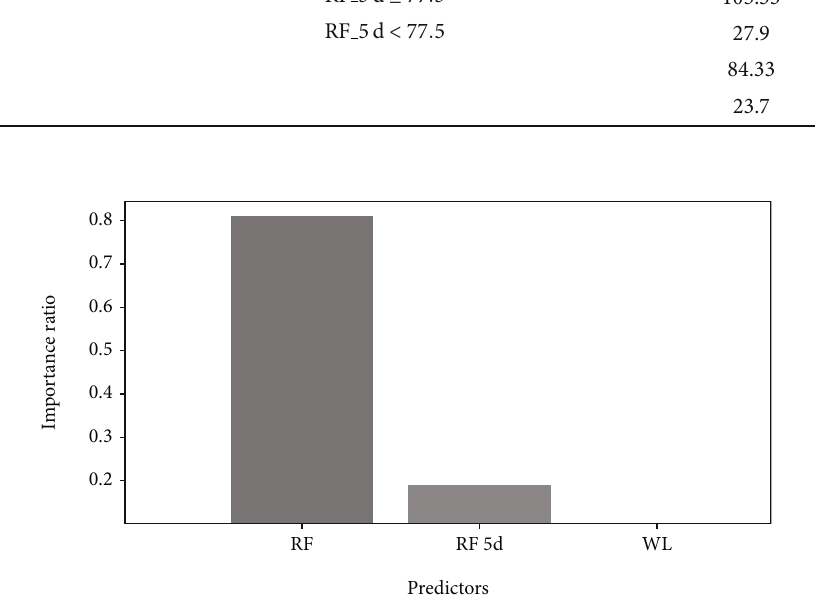
Figure 16: Predictor importance estimates for group